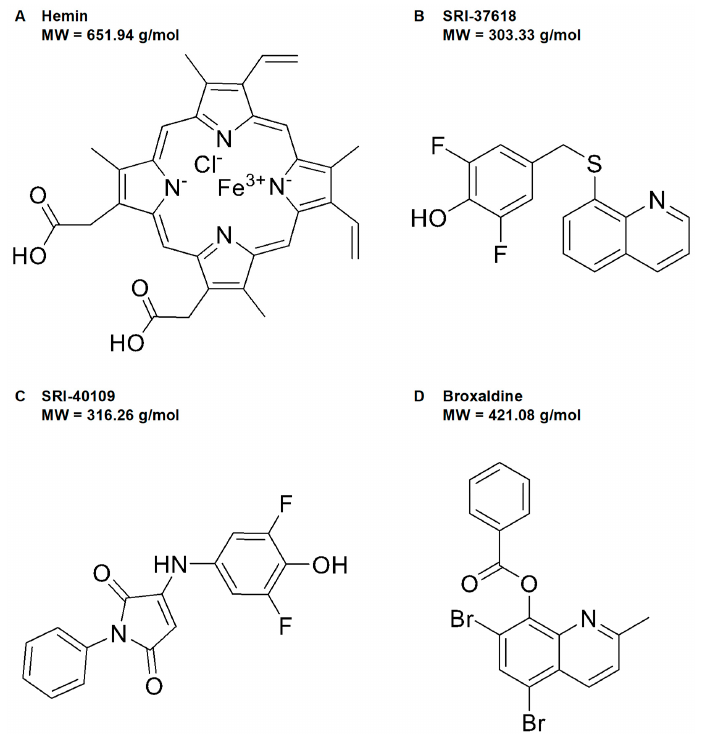
Figure 2. Structures of ( A ) hemin and ( B – D ) three small molecules identified by high − throughput screening for their ability to induce luciferase activity driven by the human HO-1 gene. MW = molecular weight.